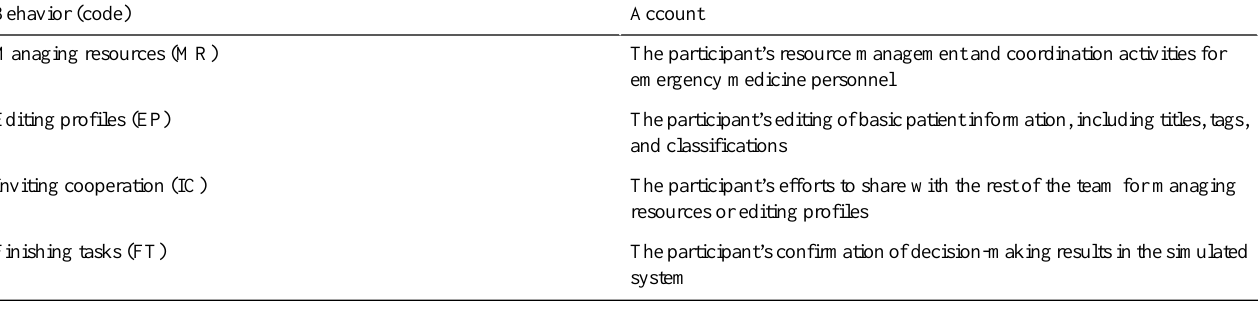
Table 2. Participatory behavior coding